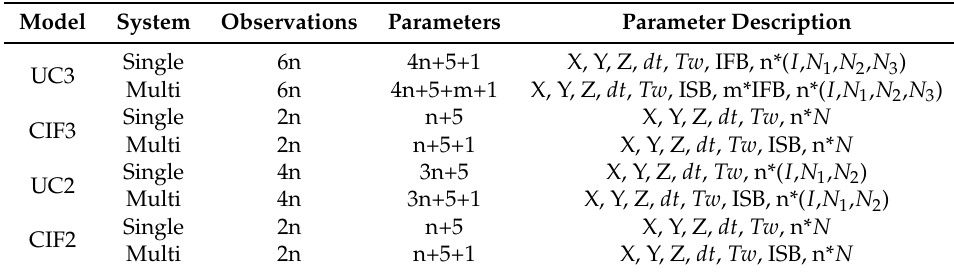
Table 1. Precise point positioning (PPP) Models comparison with multi-satellites n and multi-systems m. Uncombined model with triple-frequency (UC3), uncombined model with dual-frequency (UC2), conventional ionosphere-free model with triple-frequency (CIF3), conventional ionosphere-free